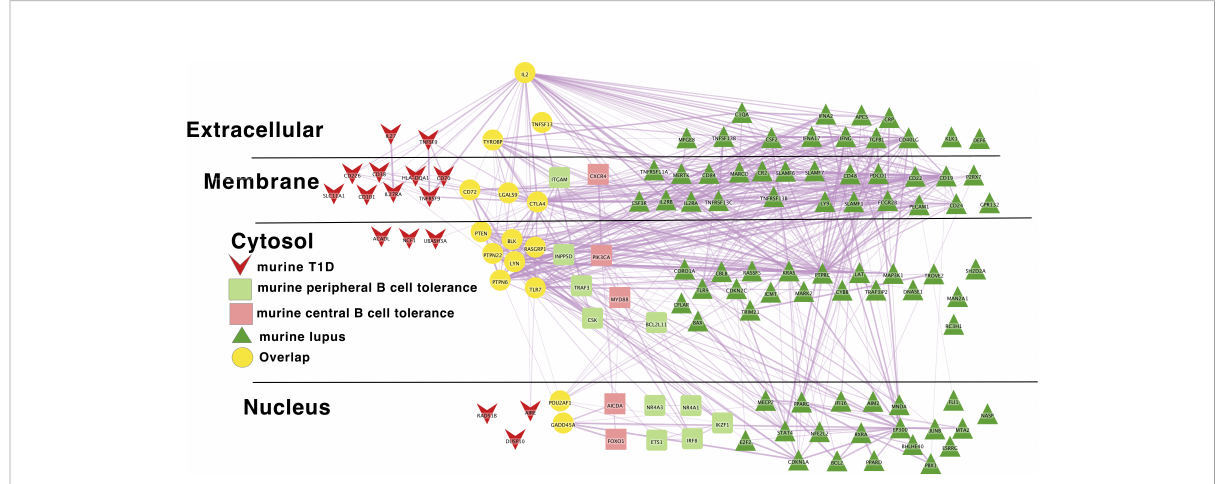
FIGURE 3 Murine autoimmune diabetes and lupus networks are densely connected to peripheral autoreactive B cell tolerance networks; dark green triangle – murine lupus gene; light green rounded rectangle – murine peripheral B cell tolerance gene; Yellow circles – overlapping genes. Downloadable/Interactive network diagram can be found at: